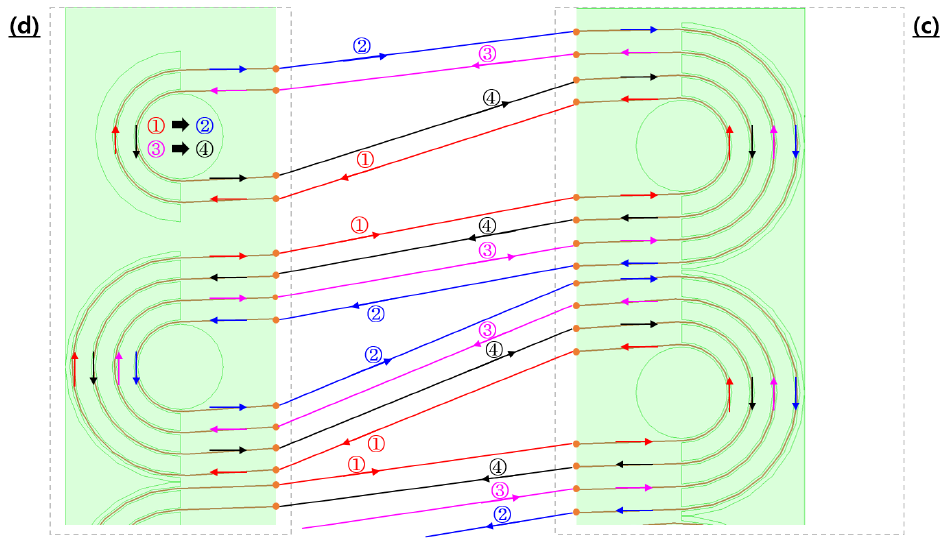
Figure 6. Winding flow diagram of ( c ) and ( d ) (top).